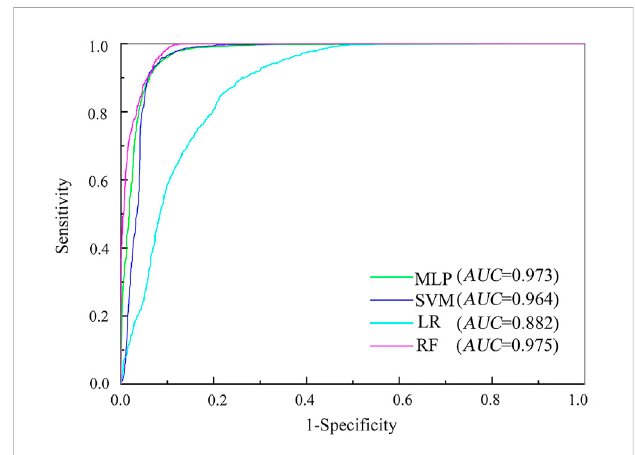
FIGURE 6 ROC curves of each model predicting fl ash fl ood